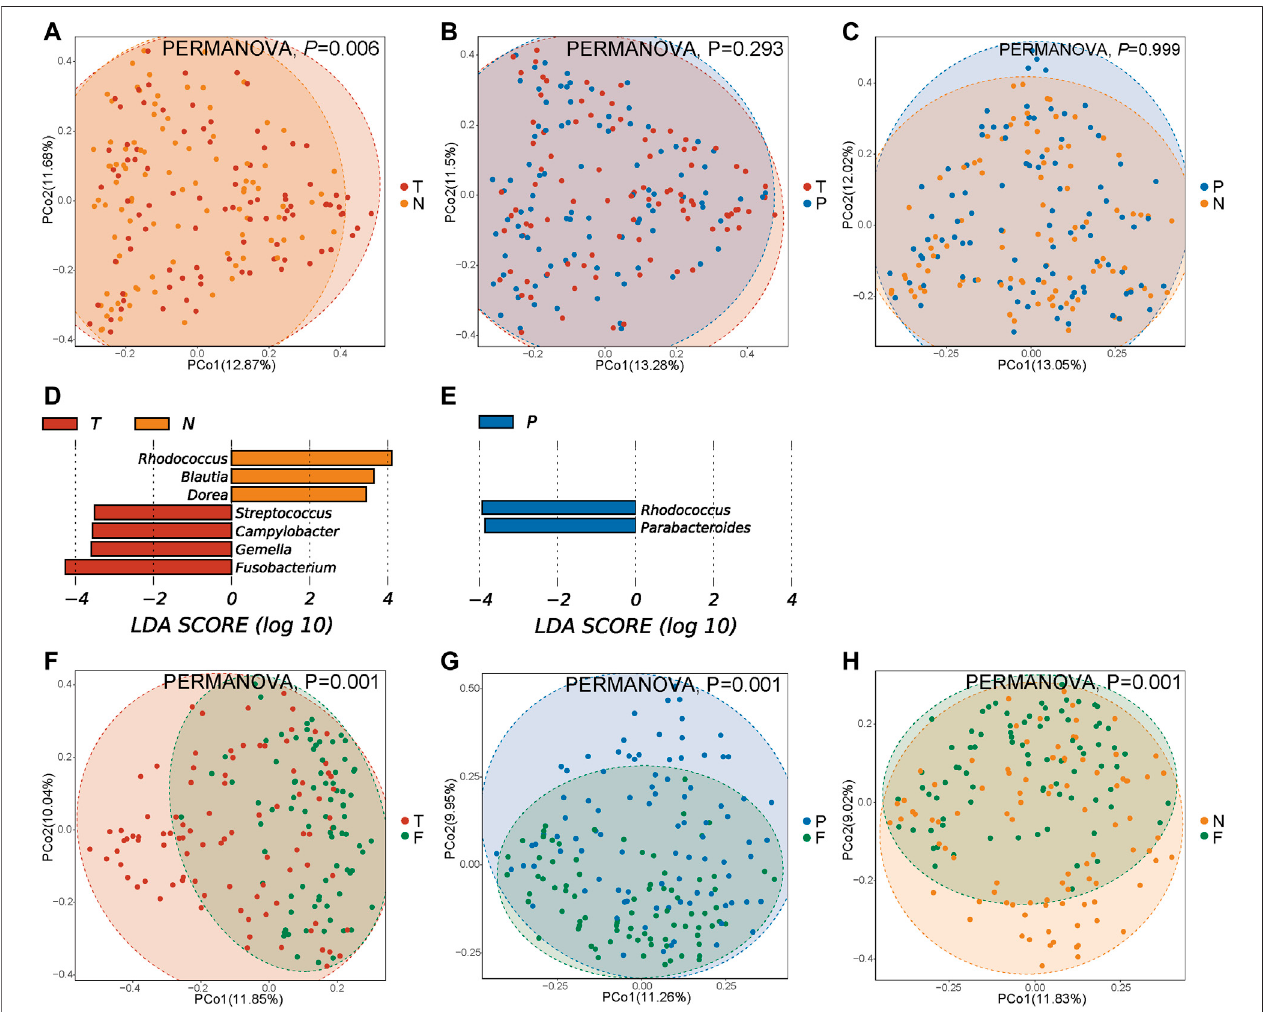
FIGURE 2 | Microbial community ecology for tumor mucosa (T), para-cancerous mucosa (P), normal mucosa (N), and feces (F) (A – C) Comparison of β diversity betweendifferentmucosalsamples (F – H) Comparisonof β diversitybetweenmucosaandfeces (D,E) HistogramsofLDAscores( > 2.0)fordifferentiallyabundantgenera between different mucosal samples (I – K) Histograms of LDA scores ( > 2.0) for differentially abundant genera between mucosa and feces (L) Relative abundance of key generainfourgroupsselectedbyLEfSeincluding Fusobacterium , Gemella , Campylobacter , Peptostreptococcus , Alloprevotella ,and Parvimonas .* p < 0.05,** p < 0.01, *** p < 0.001, **** p < 0.0001.